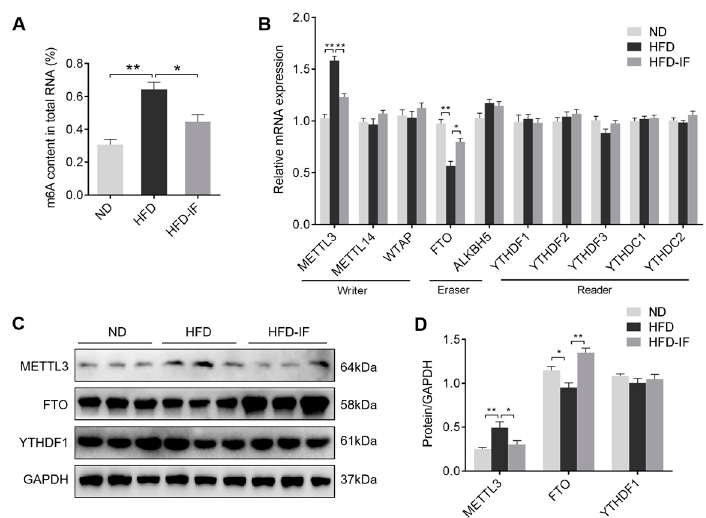
Figure 6. IF decreases cardiac m6A methylation in HFD-fed mice. ( A ) The m6A level in heart tissue samples. ( B ) RT-PCR analysis of the mRNA levels of m6A methylation-related genes in cardiac tissues related to writer (METTL3, METTL14, and WTAP), eraser (FTO and ALKBH5), and reader (YTHDF1, YTHDF2, YTHDF3, YTHDC1, and YTHDC2). ( C , D ) Western blot images and their densitometric quantitative analysis of METTL3, FTO, and YTHDF1. Data are shown as means ± SEM. * p < 0.05, ** p < 0.01.